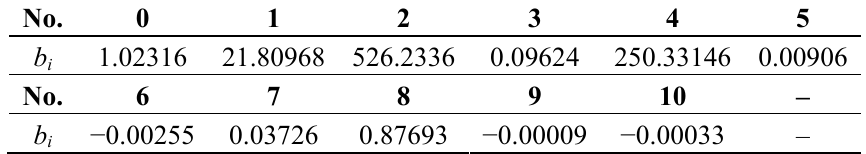
Table 1. “Magic Formula” fitting